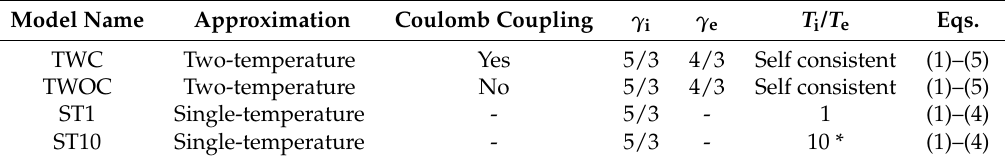
Table 2. Parameters of numerical